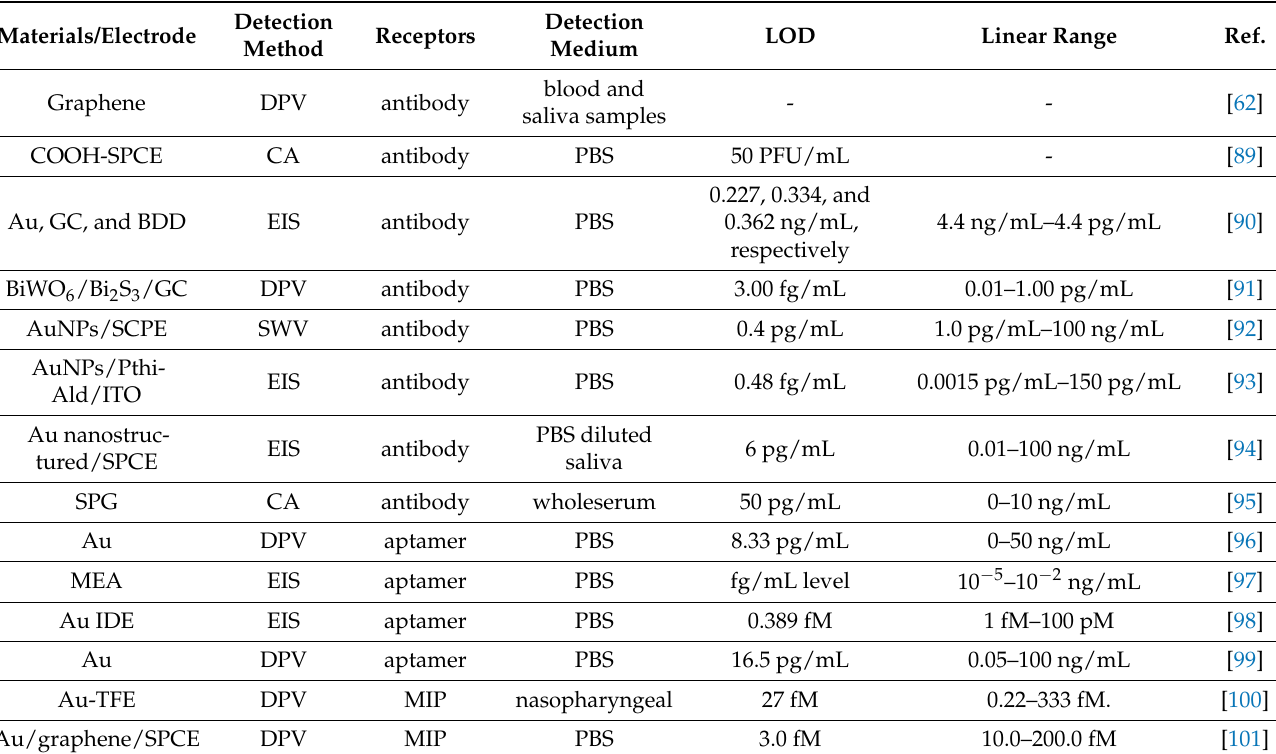
Table 4. Analytical performance of recently developed electrochemical biosensors for detecting SARS-CoV-2